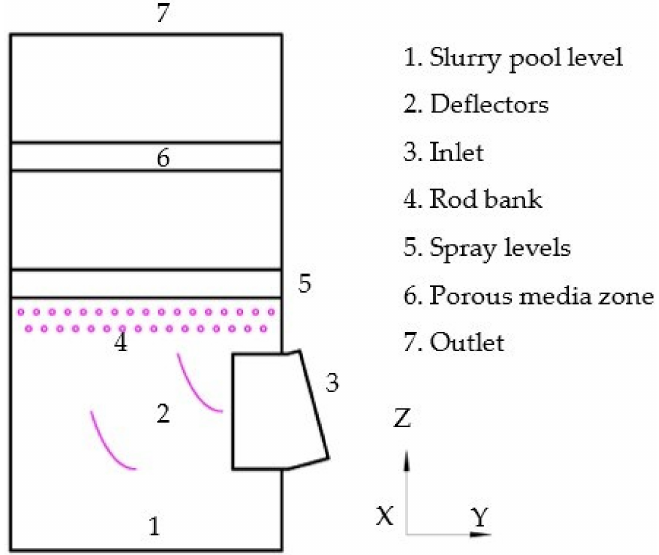
Figure 1. Setting up a computational domain.